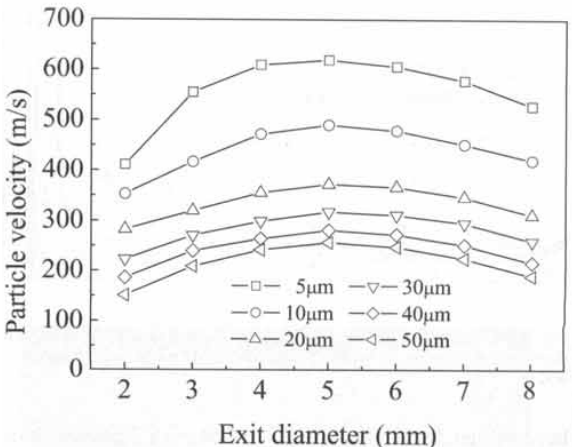
Figure 11: Effect of nozzle exit diameter on velocity of particles of different sizes using nitrogen at a pressure of 2MPa and temperture of 330°C